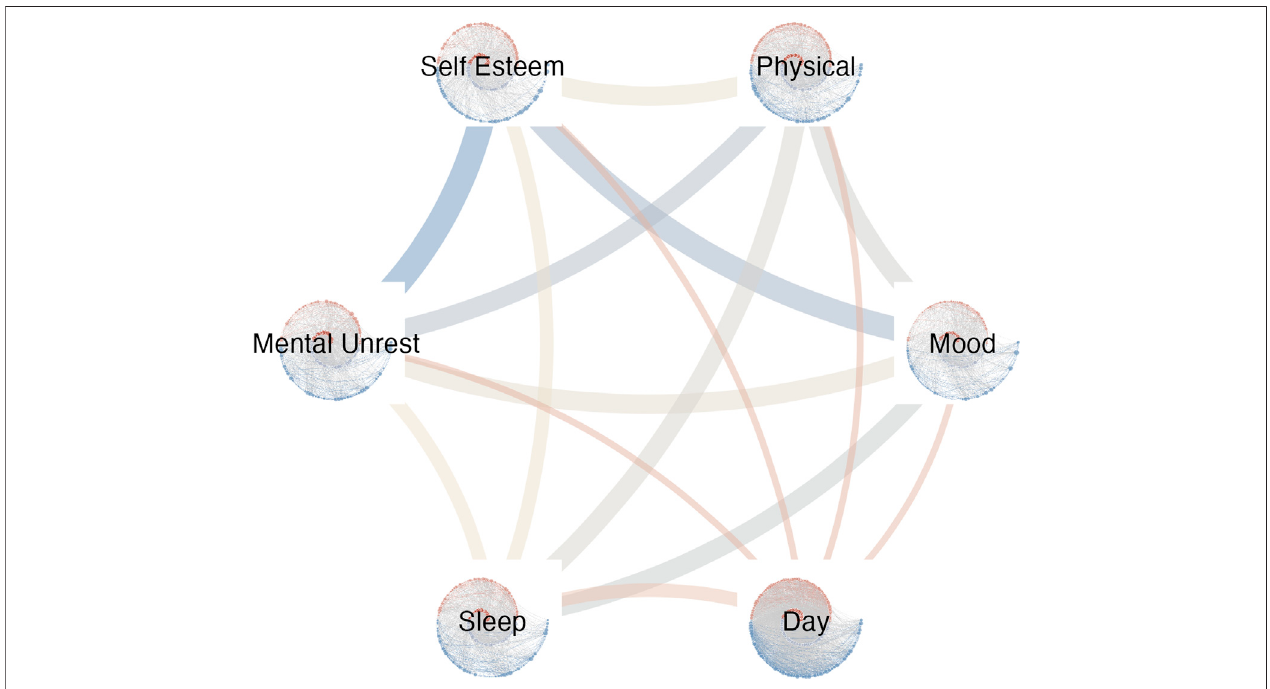
FIGURE 5 | The Multiplex network with each cRN as a layer. The edge weights and color represent the magnitude Inter-layer Mutual Information.